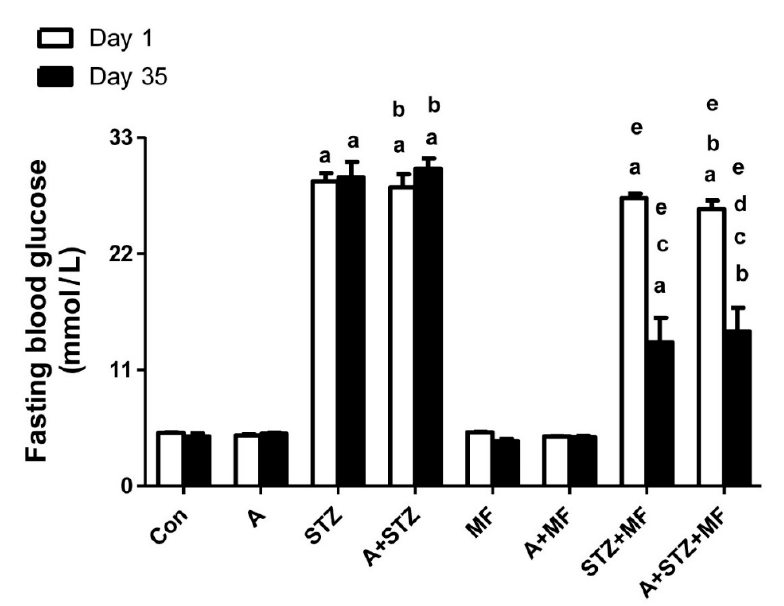
Figure 1. The fasting blood glucose level in control rats, and rats treated with metformin (MF), adenine (A) and streptozotocin (STZ) alone or in combination. Each column and vertical bar represent mean ± SEM ( n = 6). Differences between the groups were assessed by one-way analysis of variance (ANOVA) followed by Bonferroni’s multiple comparison test, where p < 0.05. a denotes significant difference between control group vs. different groups; b denotes significant difference between the group given A alone vs. other groups treated with A; c denotes significant difference between the group given STZ alone vs. other groups treated with STZ; d denotes significant difference between the group given A + STZ vs. other groups treated with A + STZ; e denotes significant difference between the group given MF only vs. other groups treated with MF.